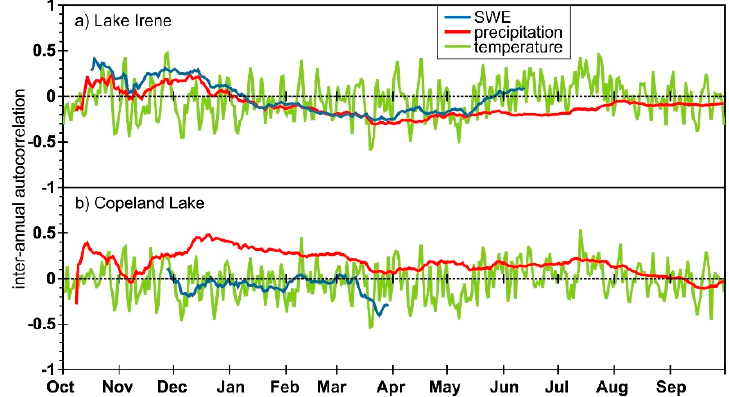
Figure 4. Inter-annual autocorrelation (1-year lag) for the daily time series of SWE, cumulative precipitation, and temperature for the ( a ) Lake Irene (see Figures 2b, 2c and 2d, respectively), and ( b ) Copeland Lake stations. SWE data are only available when snow is on the ground.